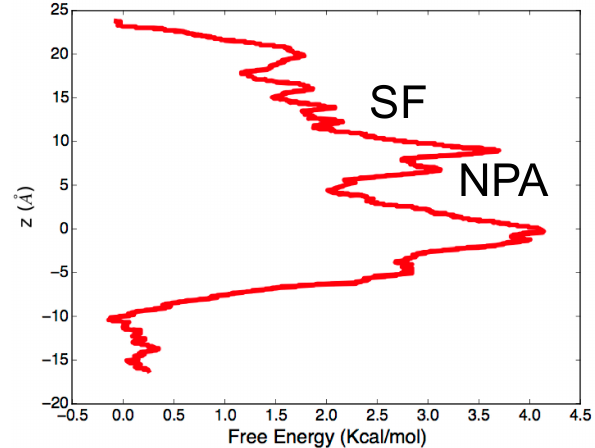
Figure 3. Free energy profile of water conduction in the hAQP4 water channel. Free energy landscape of the water transport in hAQP4 resulting from the application of Steered Molecular Dynamics (SMD) and Brownian dynamics fluctuation–dissipation theorems (BD-FDT). Data from ref [52]. For the sake of clarity, z-axis values were scaled consistently with Figure 2.